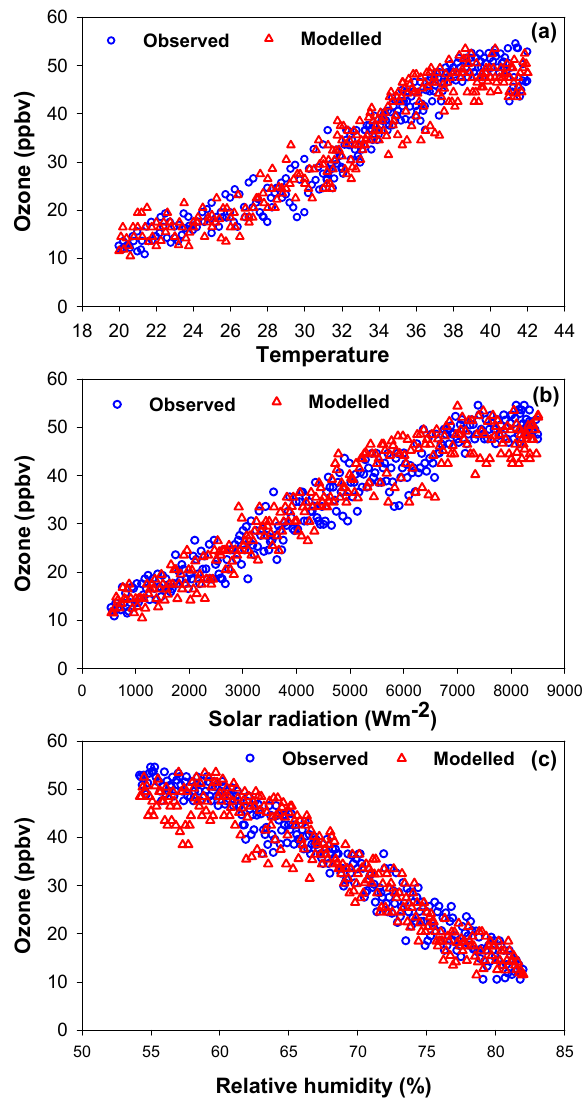
Figure 5. Scatter plot showing the correlations among ( a ) observed temperature, ( b ) solar radiation, and ( c ) relative humidity with observed and modelled ozone.